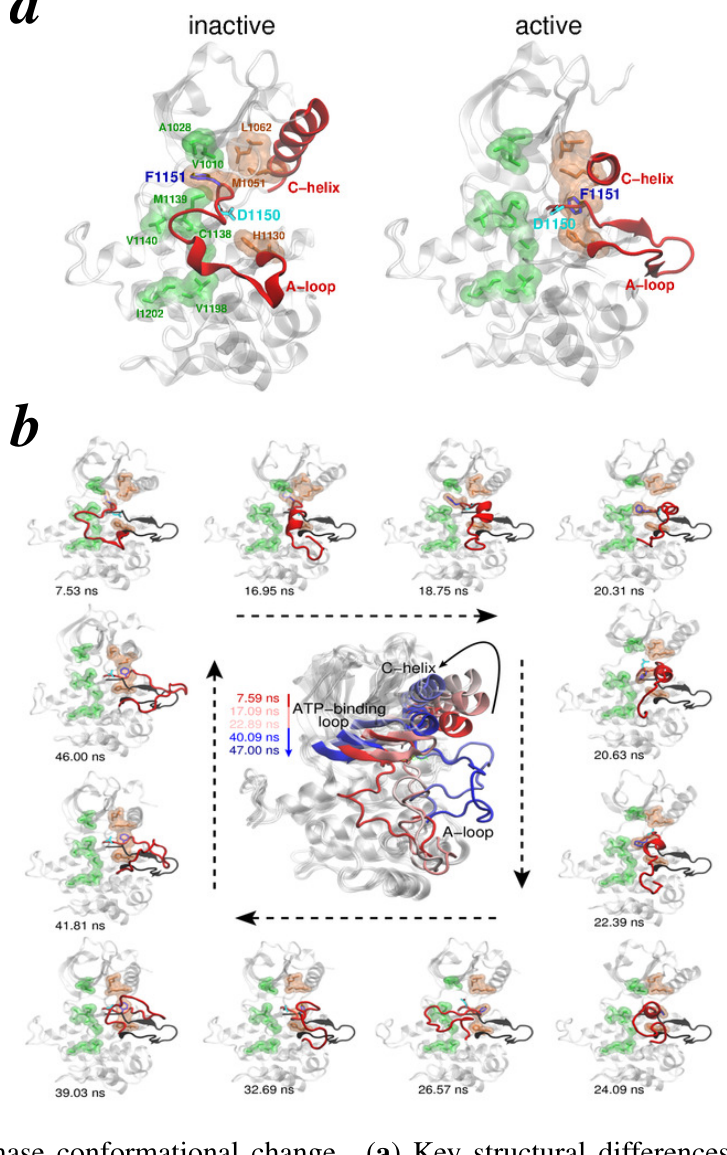
Figure 9. Kinase conformational change. ( a ) Key structural differences in the inactive (PBD Code 1IRK) and active kinase (PDB Code 1IR3) crystal structures are highlighted and labeled. The A-loop and α C-helix are shown as red cartoons, and residues of R-spine and C-spine are shown as brown and green sticks/surfaces, respectively, and labeled; ( b ) Snapshots of the kinase domain are depicted during temperature-accelerated molecular dynamics (TAMD)-generated conformational change in the A-loop. Conformation of the A-loop in the active crystal structure is also overlayed (black cartoon). Panels adapted with permission from